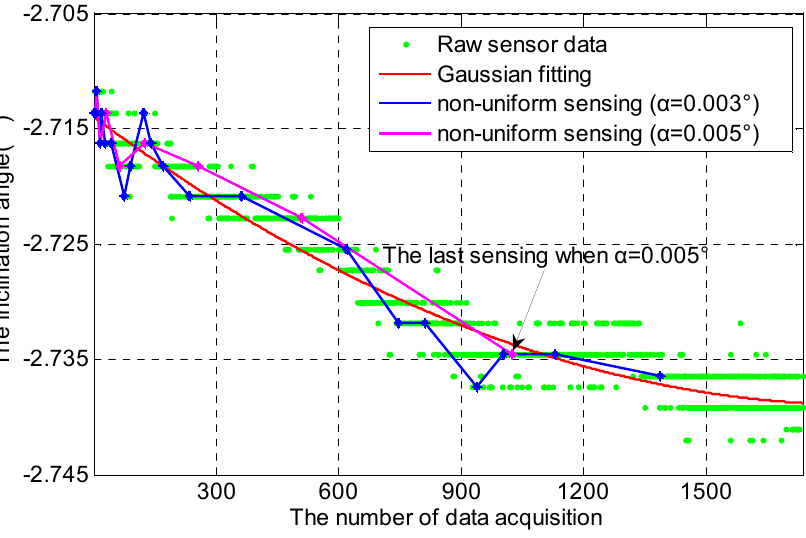
Figure 10. Non-uniform sensing with cooperative TDSS over a long-term span.